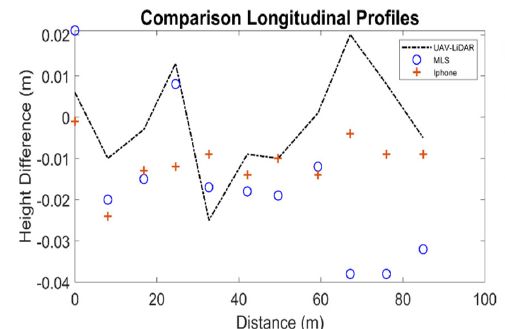
Figure 6. Comparison of different longitudinal profiles: UAV- LiDAR, MLS, and